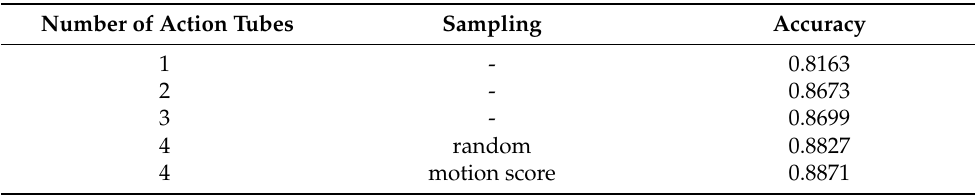
Figure 8. Examples where our proposal generates more than one action tube in a video. Person detection is illustrated with white boxes and action tubes of a different color. The first row shows a video with three action tubes, the second row presents a video with five action tubes, and the third row presents two action tubes for the video. Table 8. Ablation study varying the number of action tubes sampled per video. We report the classification accuracy on the RWF-2000 validation